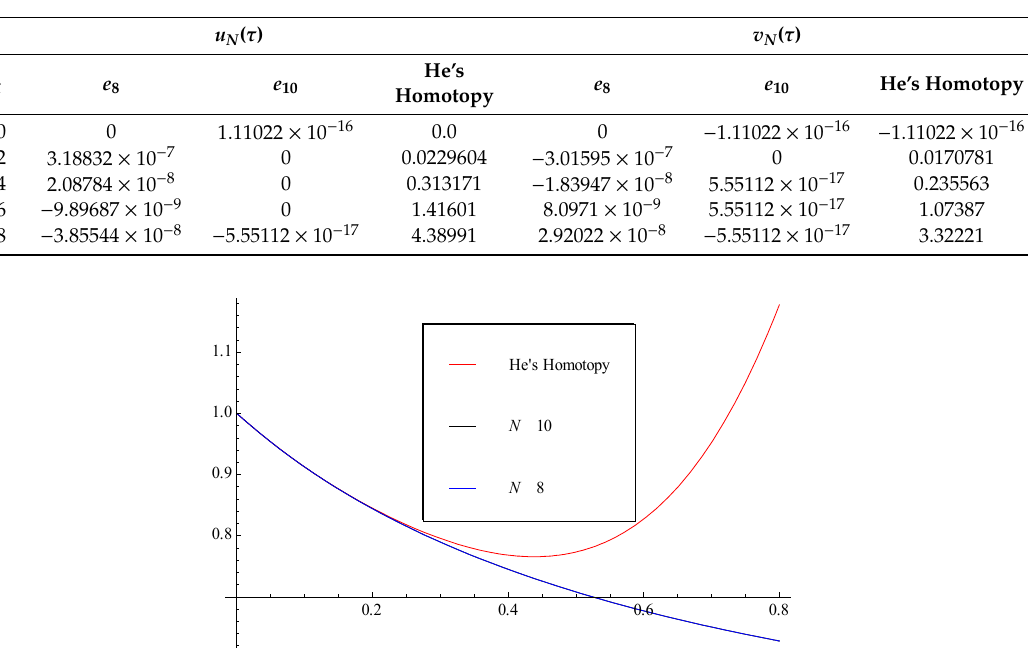
Table 8. The residual errors of the RC collocation method and He’s Homotopy.